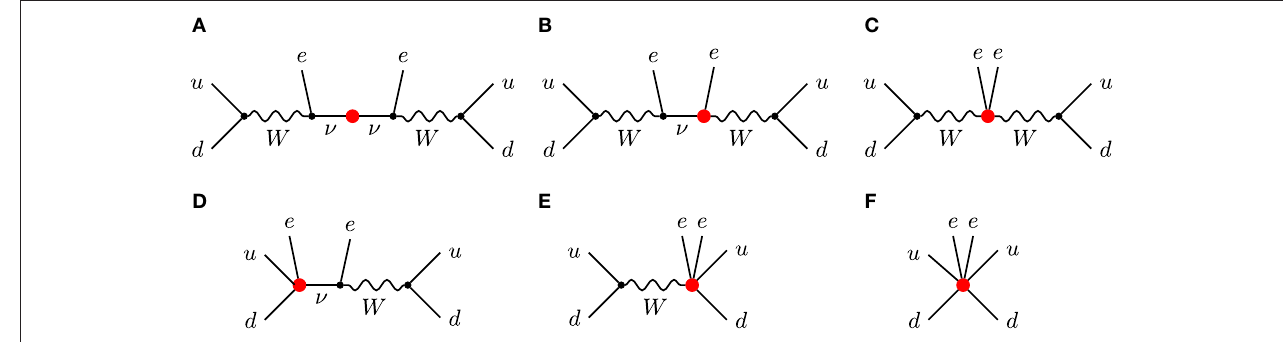
FIGURE 12 | Possible contributions to 0 νββ . The red dot indicates the 1 L